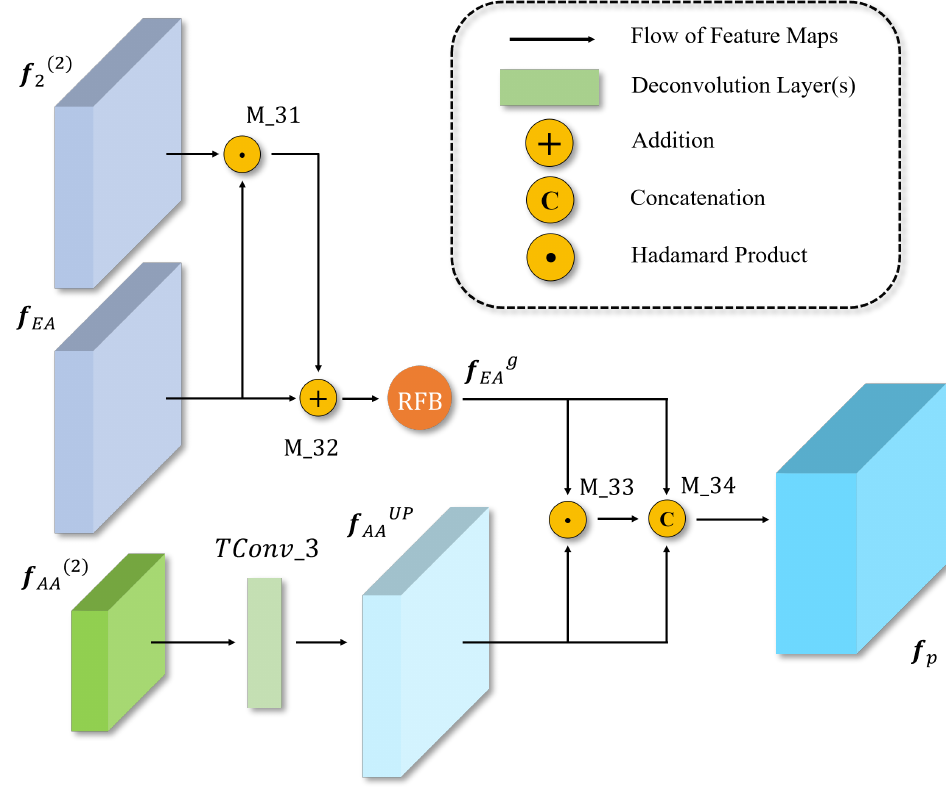
Figure 3. The detailed structure of the final prediction module